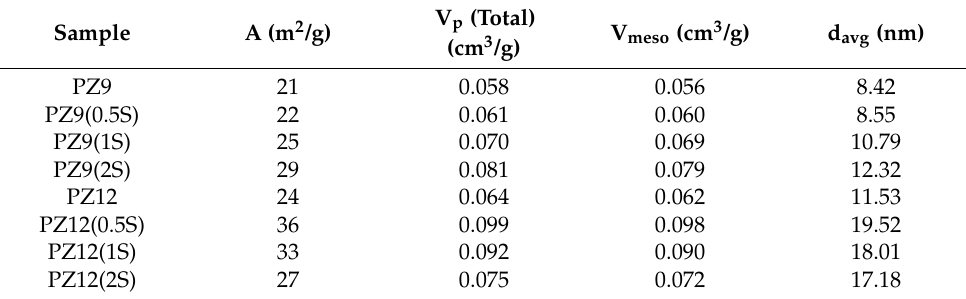
Table 3. Textural analysis of the test